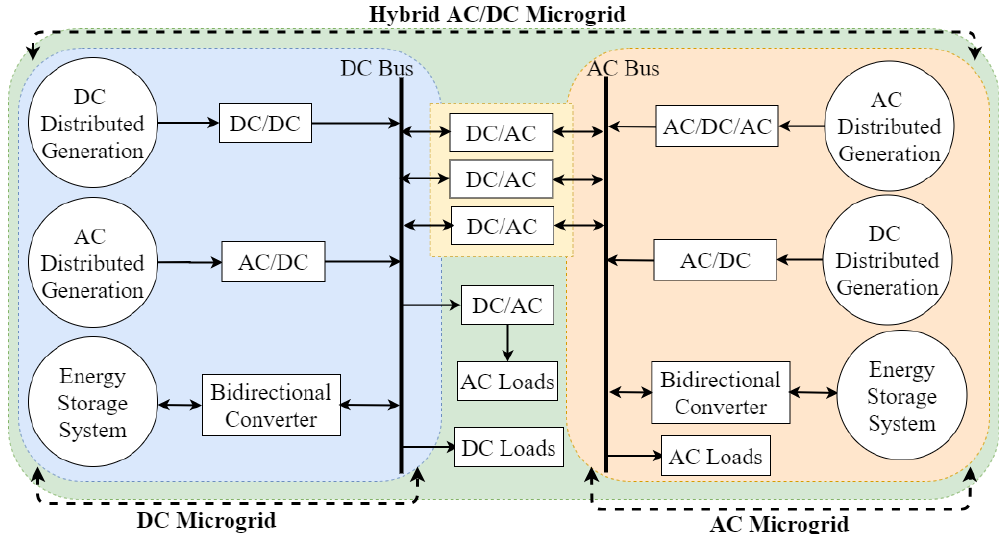
Figure 13. Typical microgrid design configuration showing the alternating current, direct current, and hybrid alternating current/direct current microgrid (Note: DC—direct current, AC—alternating current).